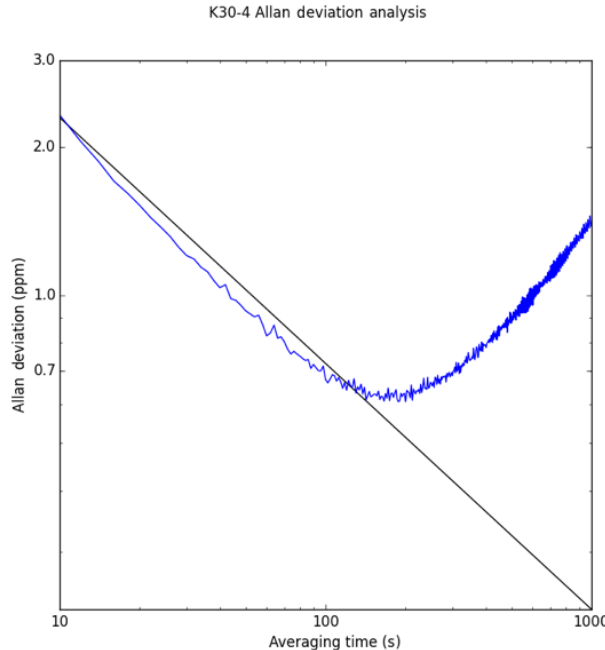
Figure 2. Allan variance analysis for an NDIR (K30) CO 2 sensor when introduced to breathing air from a high-pressure cylinder of a constant and known CO 2 concentration. Averaging times between 10 and 1000s are shown. The black line (slope − 0.5) shows where the noise is white or Gaussian. Averaging times greater than about 200s produce no